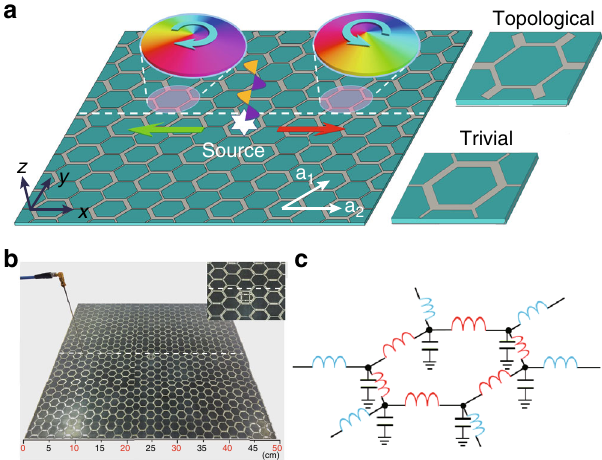
Fig. 1 Design principle of microstrip-based topological LC-circuit. a Schematics of the honeycomb microstrip structure with enlarged views of the topologically nontrivial (upper) and trivial (lower) unit cells shown in the right panels. When excited by a linearly polarized source located in the interface with a frequency within the bulk frequency band gap, electromagnetic (EM) waves propagate rightward/leftward (red/green arrow) along the interface carrying up/down pseudospin, which is represented by the phase winding of the out-of-plane electric fi eld E z accommodated in the hexagonal unit cells as indicated in the insets. b Photo of the experimental setup with a fi eld probe placed right above the microstrip array, which is used to measure the distribution of the amplitude and phase of the out-of-plane electric fi eld E z , thereby resolving the pseudospin states and pseudospin-dominated unidirectional interface EM propagation. A lumped capacitor of C = 5.6 pF is loaded on the nodes. In the lower half of the system, the metallic strips of inter/intra hexagonal unit cell have widths of 1 and 2.6 mm, whereas in the upper half they are of 3.2 and 1.5 mm, respectively, and at the interface the width of metallic strips is taken as 2.6 mm. The length of all metallic strip segments is 10.9 mm and both lower and upper halves are composed of 14 × 8 hexagons. The whole microstrip system is fabricated on a F4B dielectric fi lm with thickness of 1.6 mm and relative permittivity 2.2. c Schematic of the lumped element circuit of the hexagonal unit cells shown in the right panels of ( a